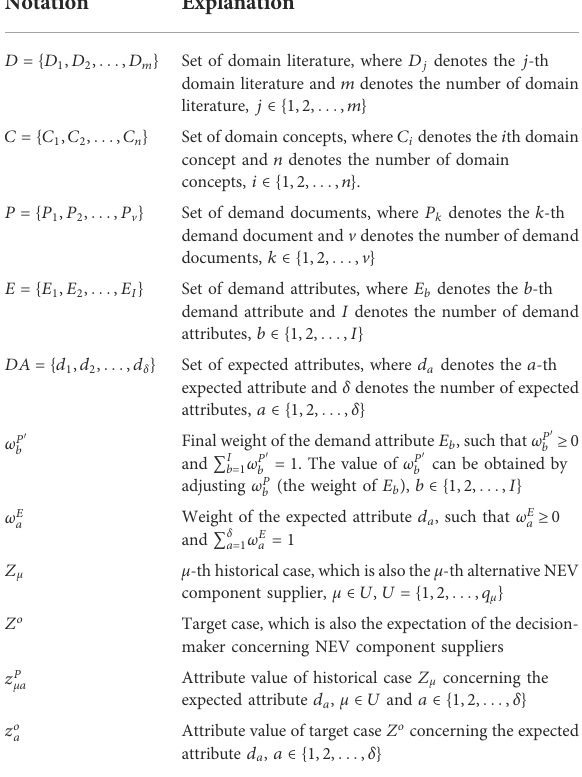
TABLE 1 Notations frequently used throughout this